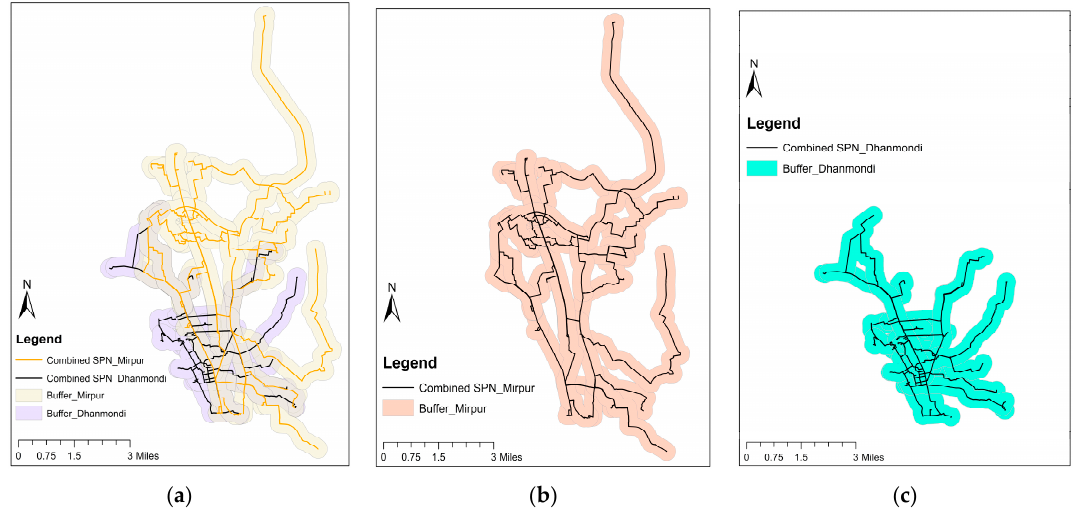
Figure 7. Shortest-path network with 400-m road network buffer of ( a ) both areas (with transparency), showing separately for the respondents of ( b ) Mirpur and ( c ) Dhanmondi